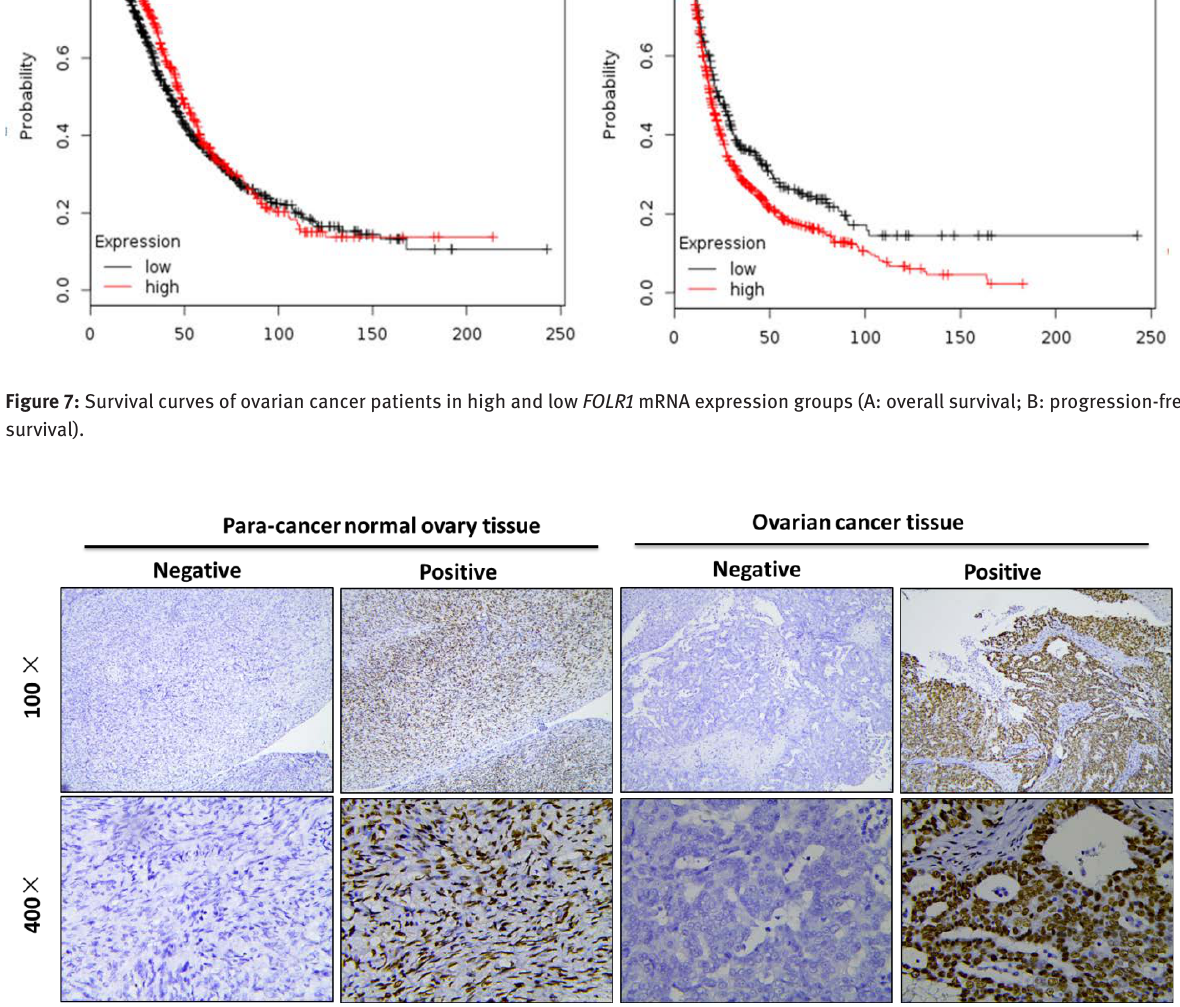
Figure 8: Immunohistochemistry assay used to assess FOLR1 expression in ovarian cancer tissue and normal ovarian